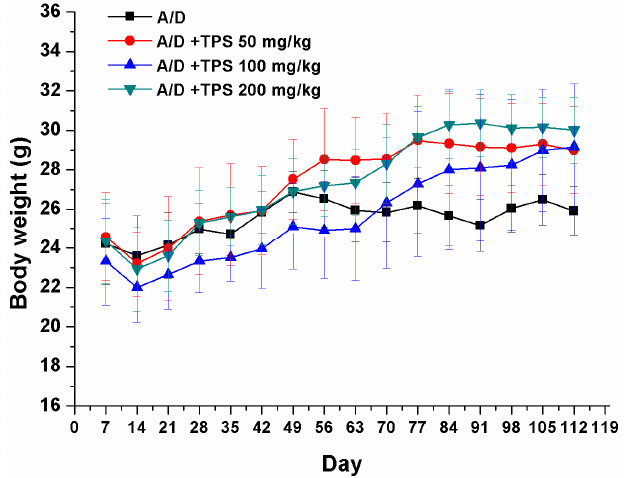
Figure 1. Base body weight changes of all groups after AOM/DSS (A/D) induction of CAC ( n = 8 mice per group). The body weight loss in AOM/DSS group was observed throughout the study